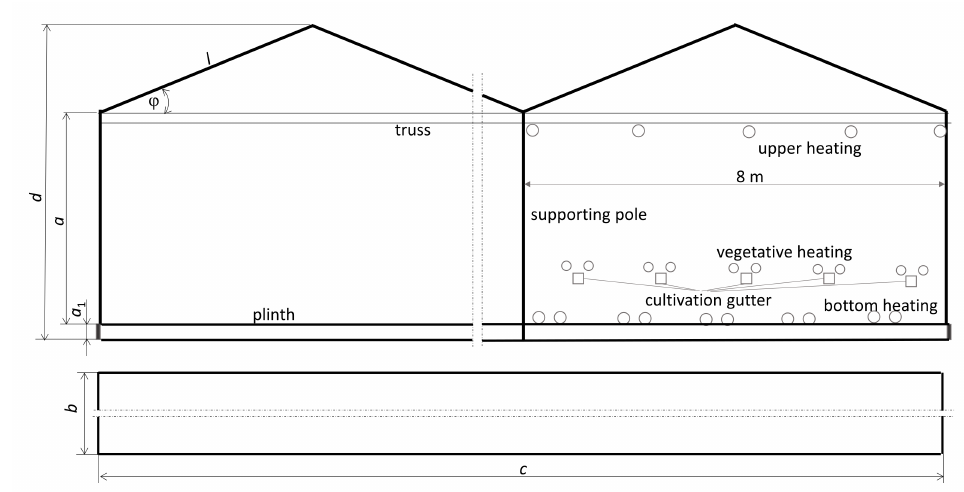
Figure 2. Scheme of the greenhouse under consideration.